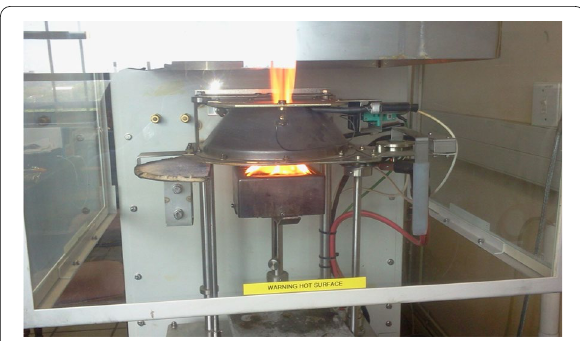
Fig. 3 Photograph of sample flaming inside the